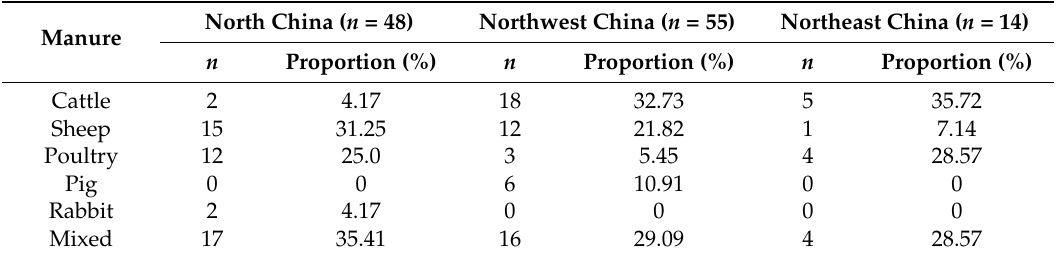
Table 1. Proportion of manure used for making organic fertilizers in the research area.